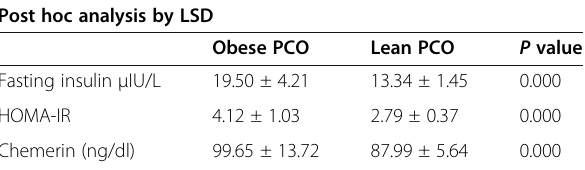
Table 5 Post hoc analysis (obese PCO and lean PCO) as regards fasting insulin, HOMA-IR, and chemerin